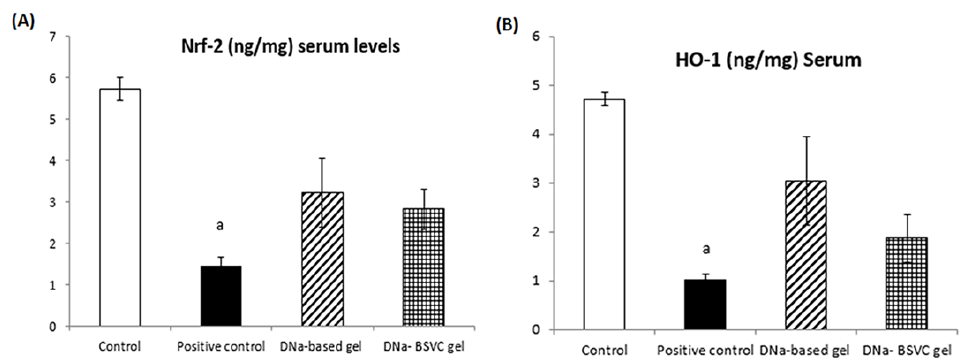
Figure 11. Treatment effects of DNa-based gel and DNa-BSVC gel on Nrf-2 in serum levels against CA-induced paw edema in rats ( A ); and HO-1 in serum levels against CA-induced paw edema in rats ( B ). Statistical analysis and the significance of difference between groups’ means were performed via one-way ANOVA, and after that a Tukey–Kramer multiple comparisons test at p > 0.05. The values are expressed as inhibitory rate (%) for 6 rats; data identified as mean ± SEM. a: significantly different from Normal